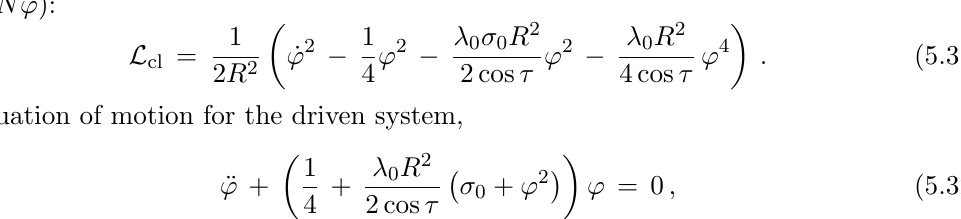
scalars in E-frame (setting all other (cid:12)elds to zero consistently, and performing a rescaling p ’ ! N’